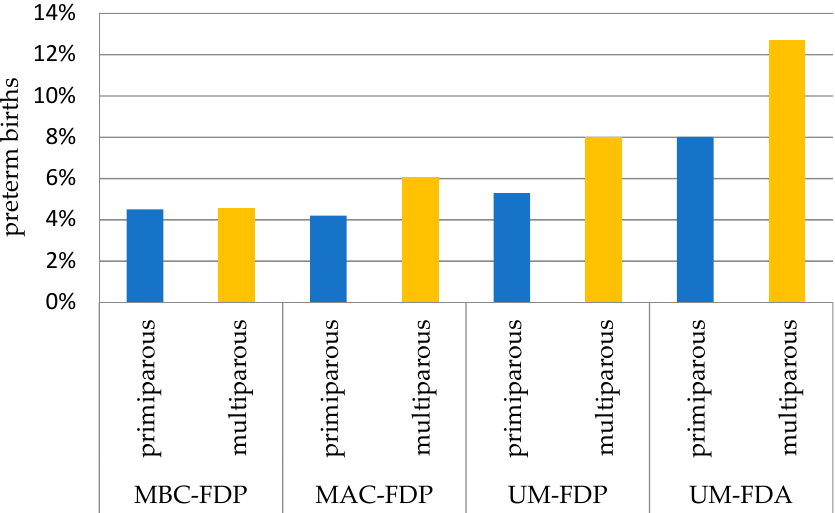
Figure 2. Preterm births by Marital-Father Data index (as a proxy of maternal psychosocial stress) and parity. MBC-FDP: married before conception & father data present; MAC-FDP: married after conception & father data present; UM-FDP: unmarried & father data present; UM-FDA: unmarried & father data absent.